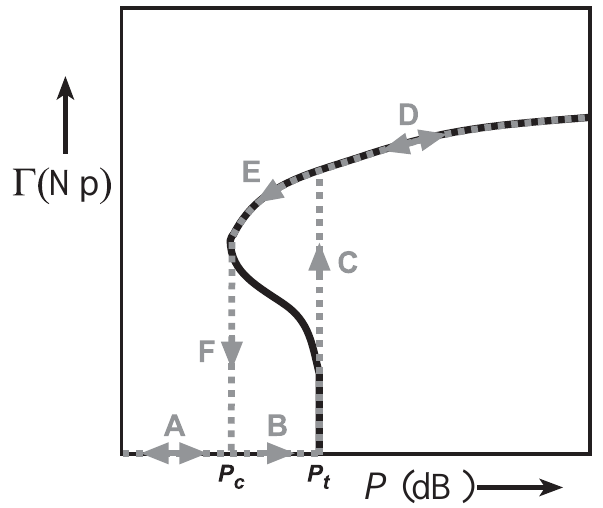
Fig. 1. A theoretical curve showing the relationship between anomalous absorption and heater power (solid curve). The dashed lines show the different paths that lead to the hysteresis effect. Current theory suggests that the FAI are generated by the thermal parametric instability (TPI). There are two regimes of the TPI which relate to soft and hard excitation, depend- ing on whether initial density perturbations are infinitesimal or finite respectively (e.g., Istomin and Leyser, 1997). The former regime corresponds to the thermal oscillating two- stream instability (TOTSI; e.g. Grach et al., 1978; Dysthe et al., 1983) while the latter regime is the resonance instabil- ity reported by Vaskov and Gurevich (1977). The nonlinear stage of the soft regime resembles the resonance